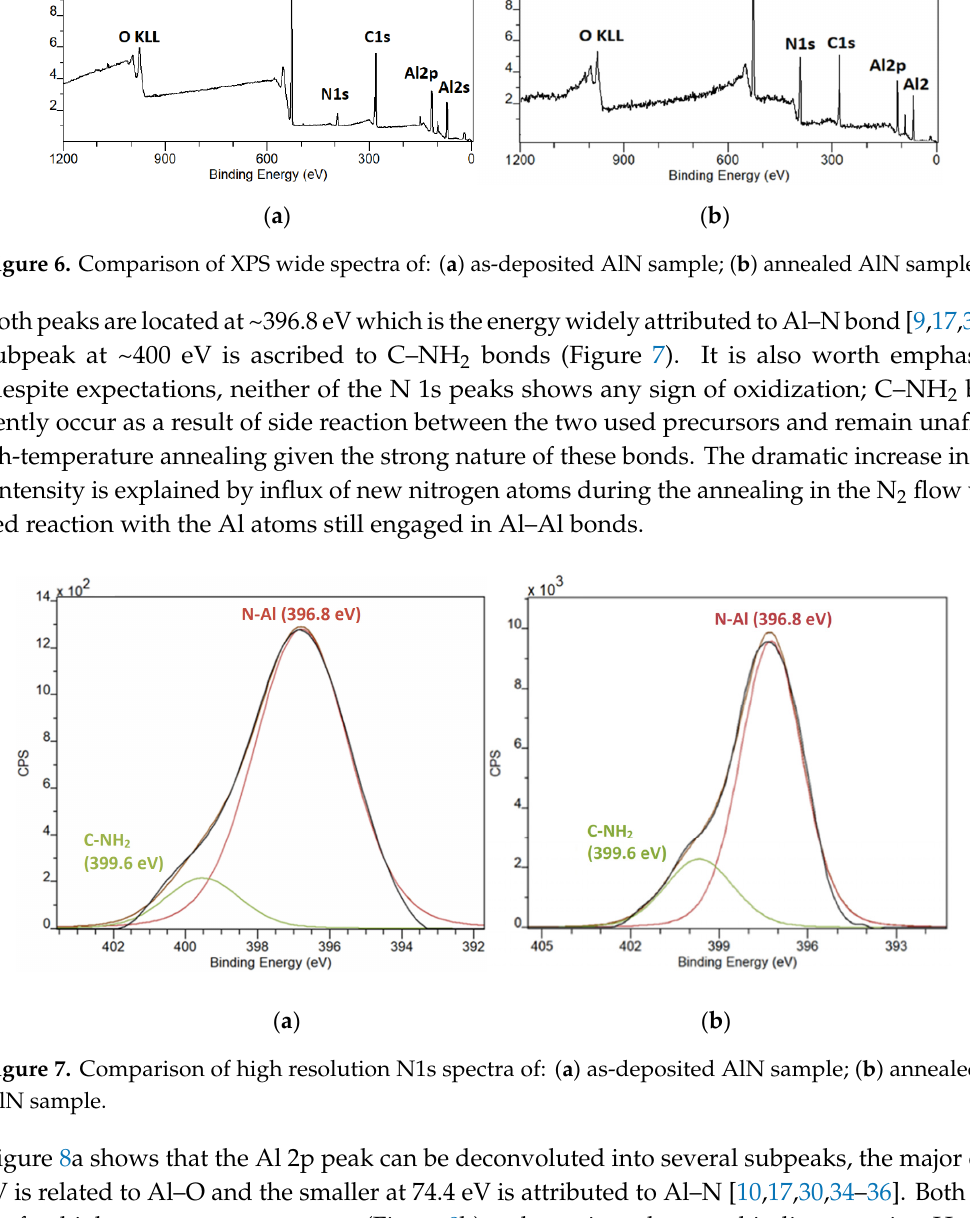
Figure 6. Comparison of XPS wide spectra of: ( a ) as-deposited AlN sample; ( b ) annealed AlN sample.